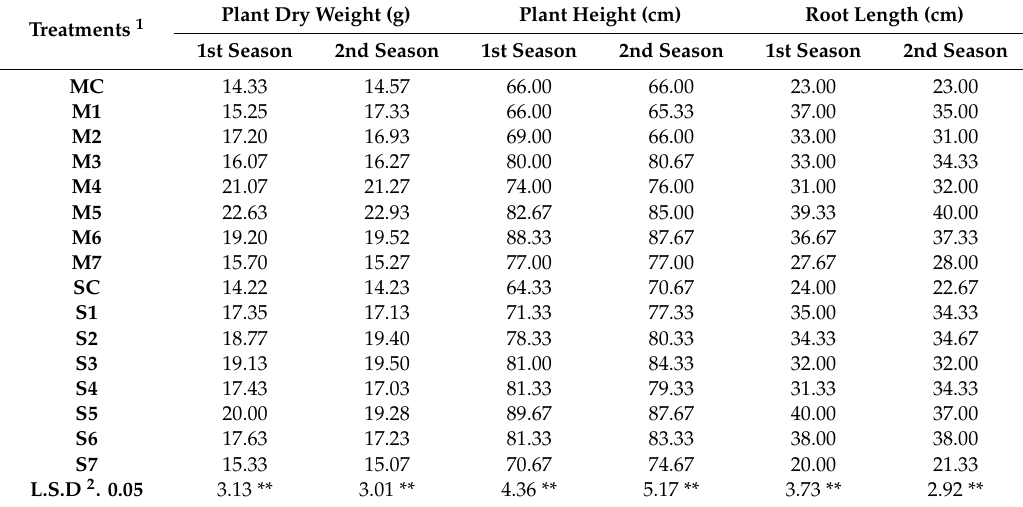
The presence of asterisks indicates that there were statistically significant di ff erences between treatments. ** p < 0.01. Table 4. E ff ect of spent mushroom substrate extract (SMSE), mushroom culture filtrate (MCF), and Roundup ® treatments to control broomrape infestation on plant dry weight (g), plant height and root length in faba bean plants at 60 days from sowing during two